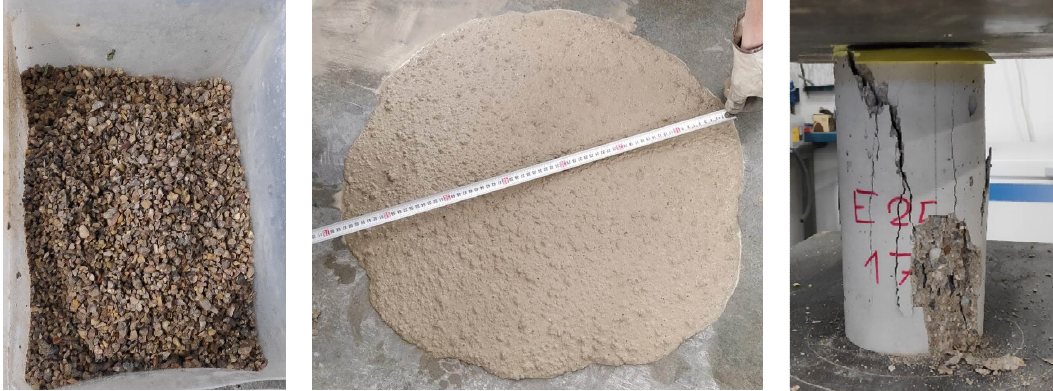
Figure 2. Highlights of the experimental plan: coarse RCA pre-soaked ( left ), slump-flow test of mix SA50 ( middle ), and specimen tested for compressive strength ( right ).